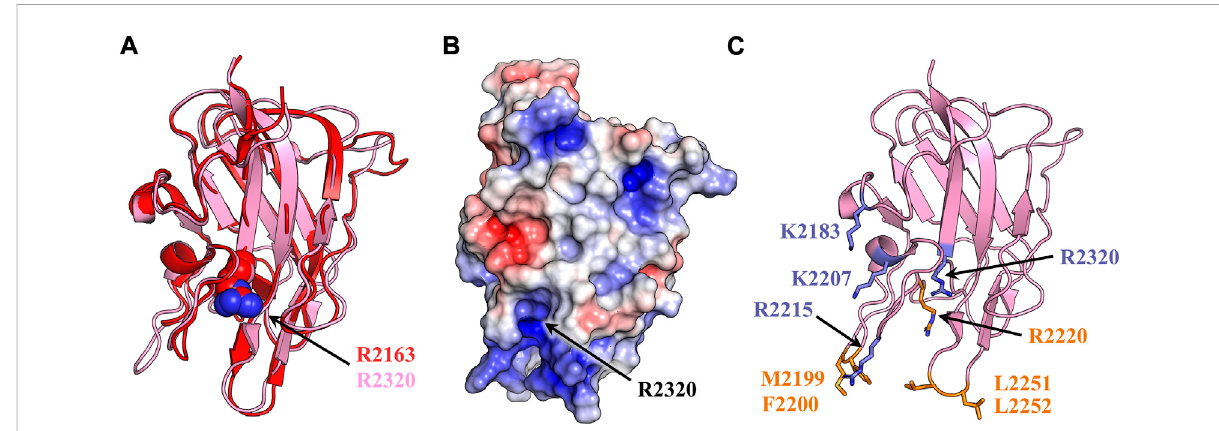
FIGURE 1 fVIII C2 domain structural homology and membrane binding model. (A) Structural alignment of fVIII C1 (red) and C2 domain (light pink) (PDB: 6MF2).Bothdomainsconsistofahomologous β -barrelmotifandthreesolventexposedhydrophobicloops.Spheresrepresentaconservedarginine (red:R2163,lightpink:R2320). (B) SurfaceelectrostaticmappingoftheC2domain.ResidueR2320islocatedinthemostbasiccleftoftheC2domain. The surface potential calculation was performed in PyMOL with APBS using a surface potential value of ±5 kT/e (blue: positive charge, red: negative charge, white: neutral). (C) Anti-C2 classical antibody inhibitors 3E6 and BO2C11 disrupt fVIII binding to lipid membranes. Sticks represent membrane-binding residues which become buried upon binding to 3E6 (slate) or BO2C11